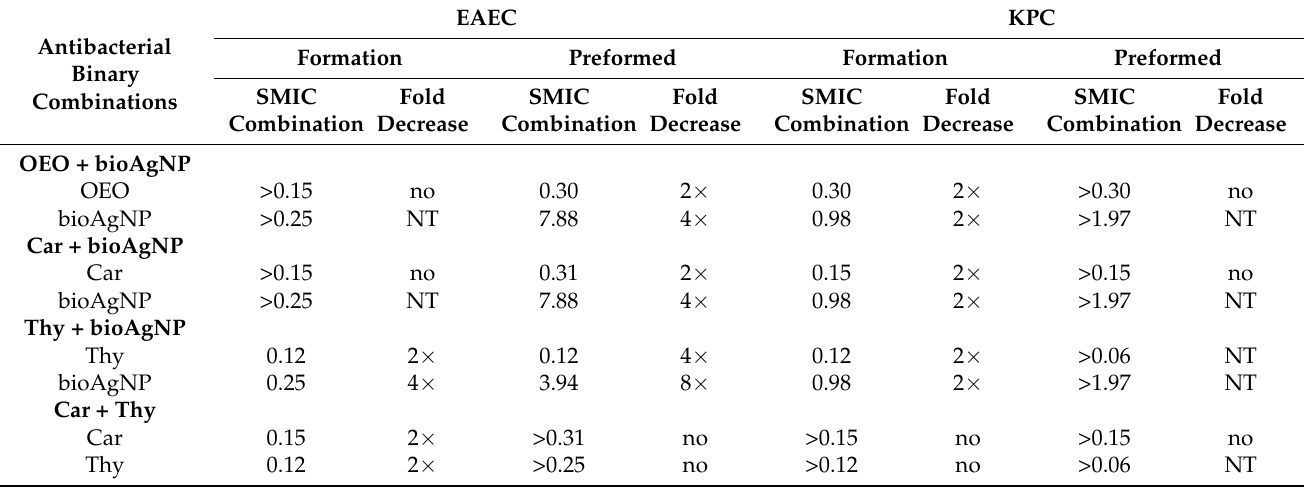
Table 2. Sessile minimal inhibitory concentration (SMIC ≥ 95 ) of oregano derivatives (mg/mL) and biological silver nanoparticles (bioAgNP, µ g/mL) in binary combinations against enteroaggregative Escherichia coli (EAEC 042) and KPC-producing Klebsiella pneumoniae (KPC), at both early stage